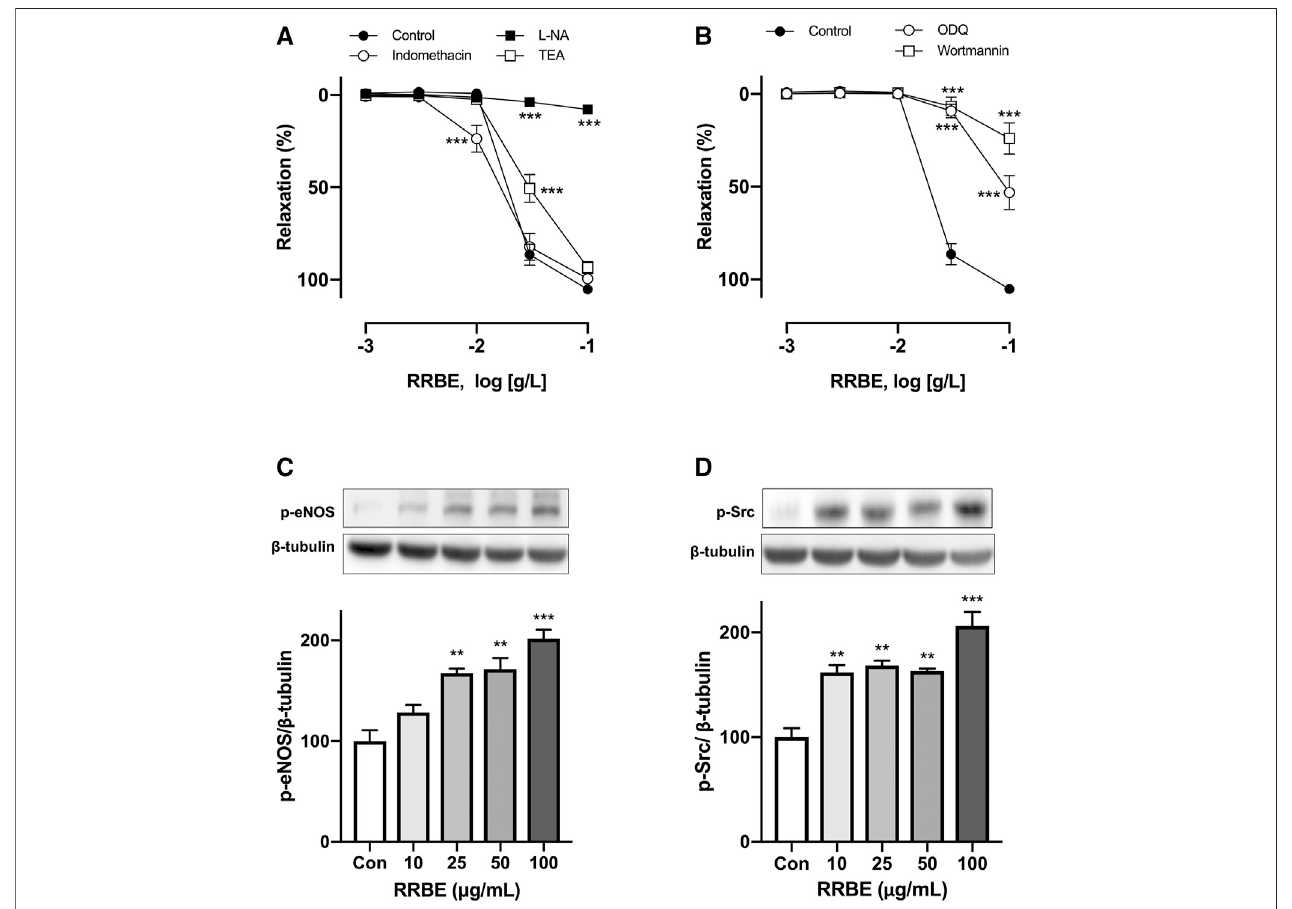
FIGURE 3 | Characterization of endothelium-dependent relaxations in response to RRBE in coronary artery rings. Intact rings were incubated with (A) the NO synthase inhibitor (L-NA, 100 μ M), cyclooxygenase inhibitor (indomethacin, 10 μ M), and non-selective potassium channel blocker (TEA, 1 mM), in addition to (B) sGC inhibitor (ODQ, 10 μ M) and PI3K inhibitor (wortmannin, 30 nM) for 30 min before the addition of U46619. Results are presented as mean ± SEM of 9 – 12 experiments. ***p < 0.001 vs Control. Representative and cumulative data of phosphorylation level of eNOS at Ser1177 (C) and Src at Tyr418 (D) in endothelial cells exposed to